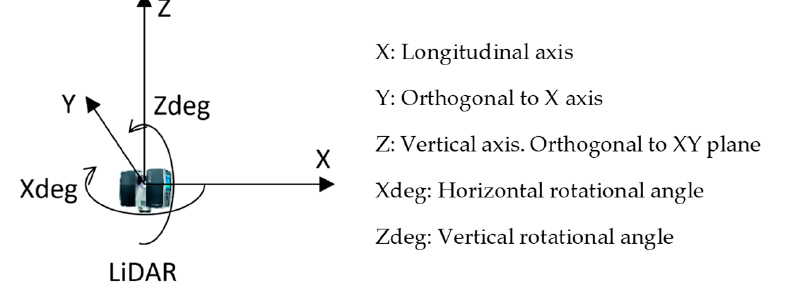
Figure 6. Global Sign Convention.